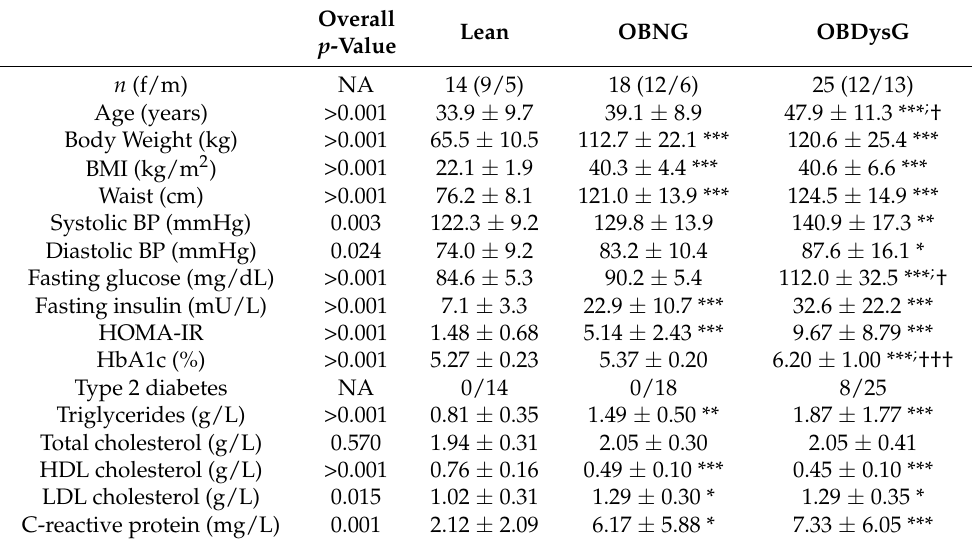
Table 1. Anthropometric, clinical and biological characteristics of the